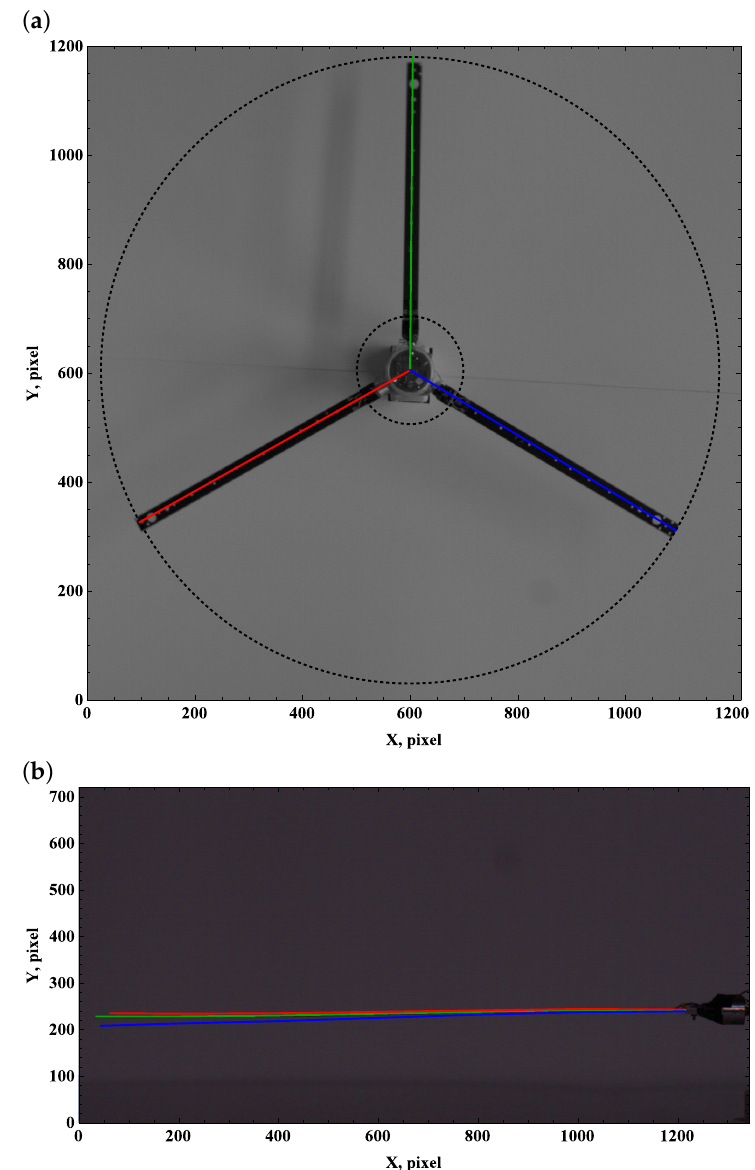
Figure 4. Preset angle 0 0 , angular speed 100 rpm: top view ( a ), side view ( b